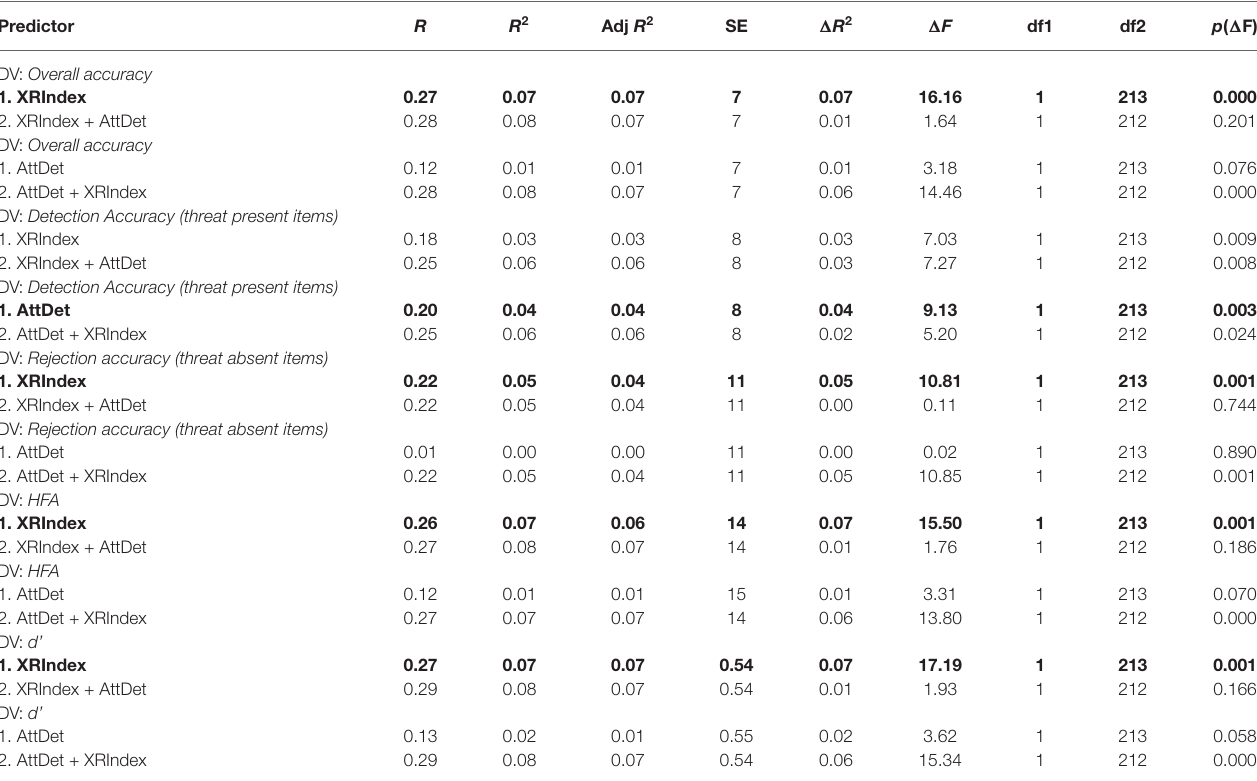
TABLE 4 | Hierarchical regression models having either the XRIndex score or the Attention to Detail (AttDet) score as predictor at Stage 1, and both scores at Stage 2 on all indices of performance.